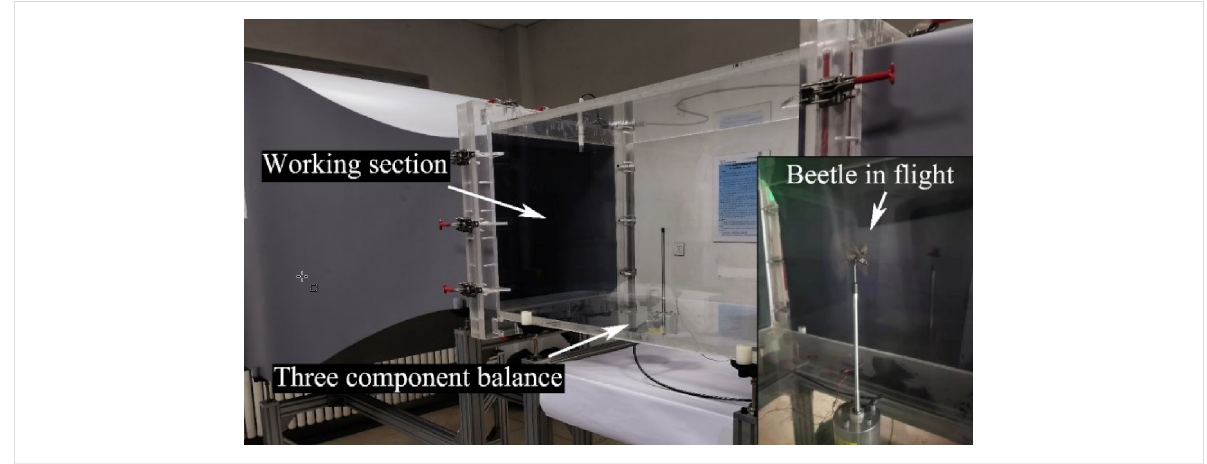
Figure 1: The low-speed straight-flow wind tunnel and the beetle during test.